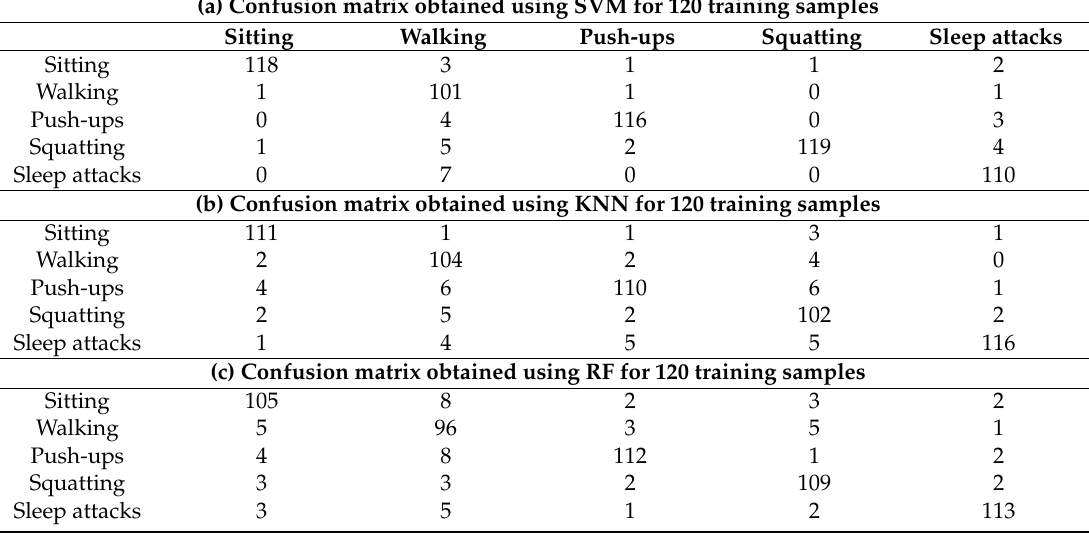
Table 4. Classification results considering different approaches.